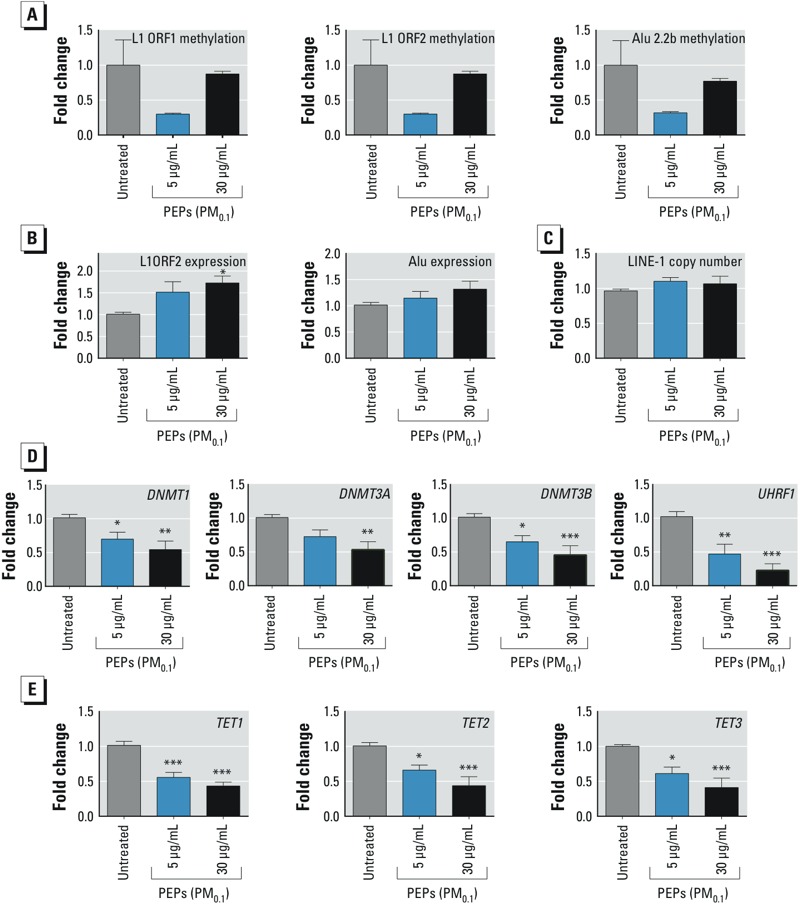
DNA methylation in SAECs exposed to PEPs for 24 hr compared with that in the untreated control. (A) Fold change in 5-meC in TEs; (B) mRNA expression of TEs; (C) LINE-1 copy number; (D) expression of DNMTs and accessory protein UHRF1. (E) Expression of methylcytosine deoxygenases (TET1-TET3) in SAECs exposed to PEPs for 24 hr. All values are represented as the mean ± SE. *p< 0.05. **p< 0.01. ***p< 0.001.